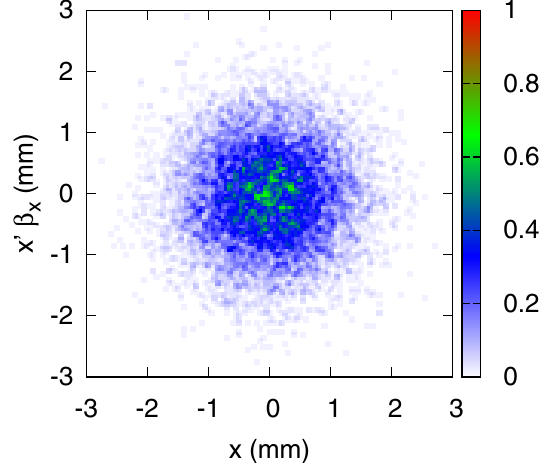
FIG. 3. Distribution of final positions of a test particle initial- ized at x ¼ 0 , x 0 ¼ 0 after tracking in a constant focusing channel for n ¼ 10000 different random initializations of macroparticles. The distribution is normalized to the number of particles found in the